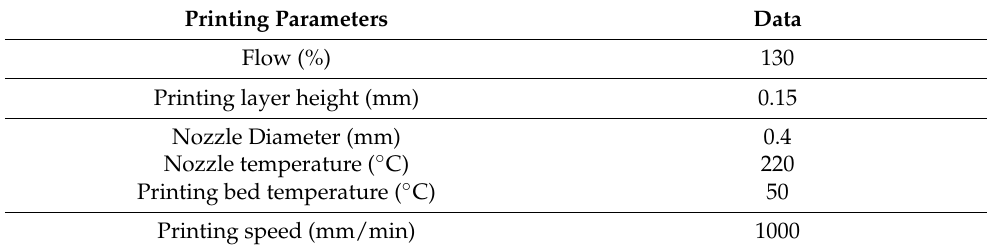
Table 1. Parameters for the FDM processing of TPU